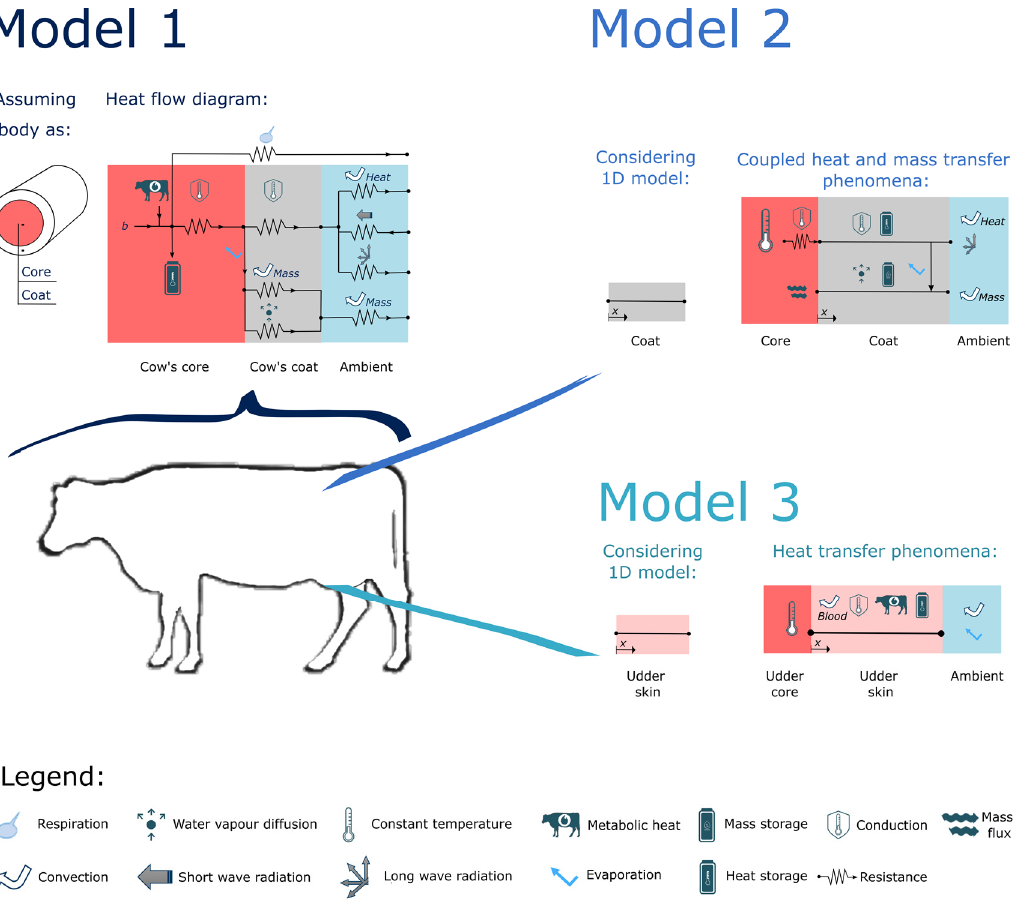
Figure 2. Representation of three independent mechanistic models developed for different zones of the cow: entire body (model 1, [114]), coat (model 2, [110]), and udder (model 3, [115]).